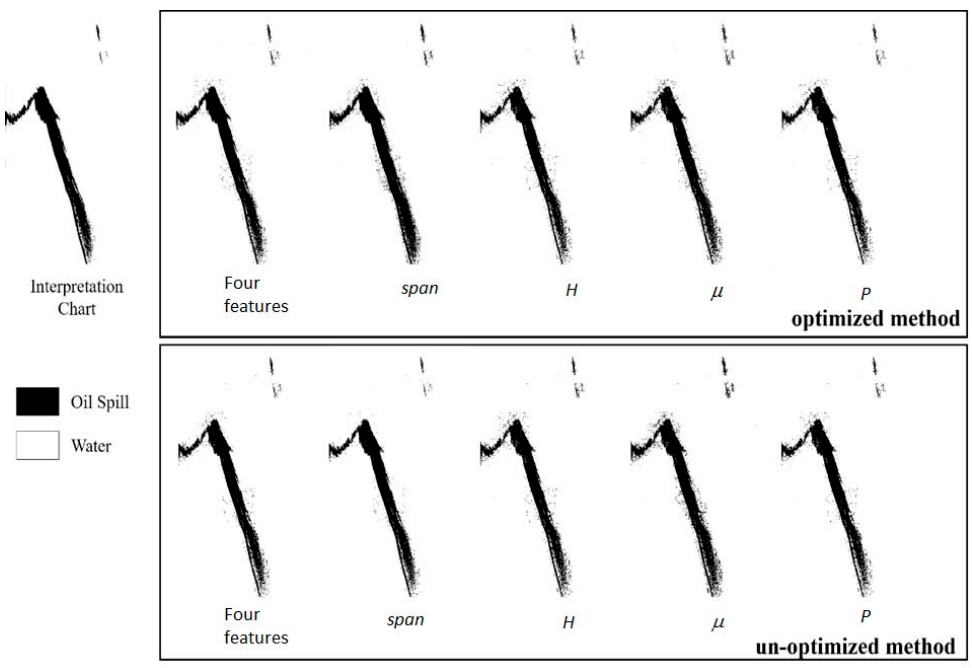
Figure 11. Classification results of Dataset 1.